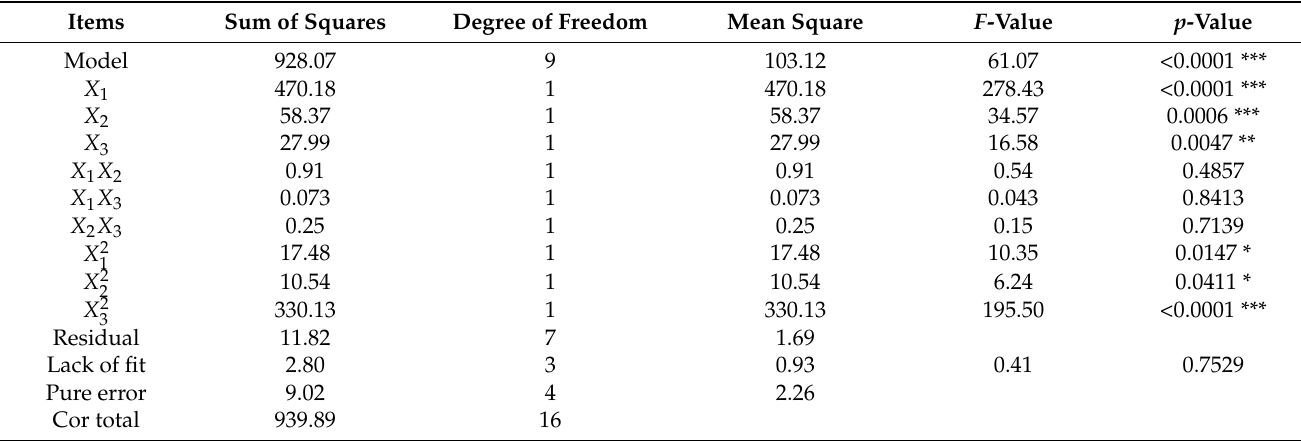
Table 5. ANOVA of the bruise